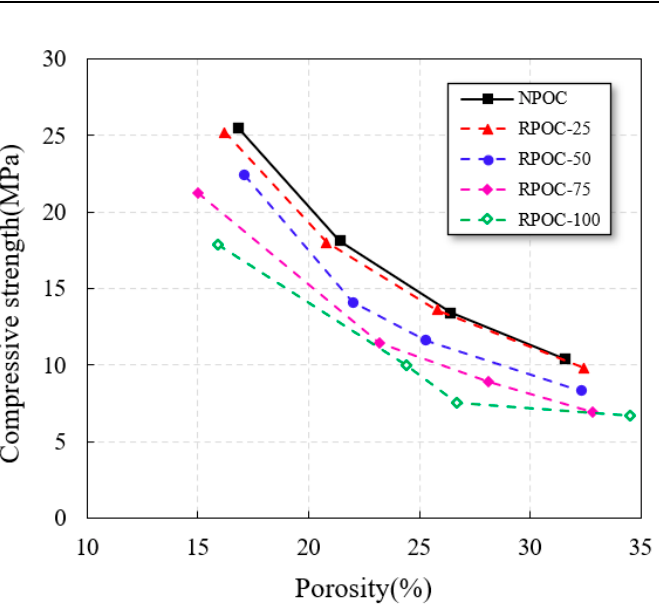
Figure 7. The compressive strength of porous concrete changes with the replacement rate of recycled